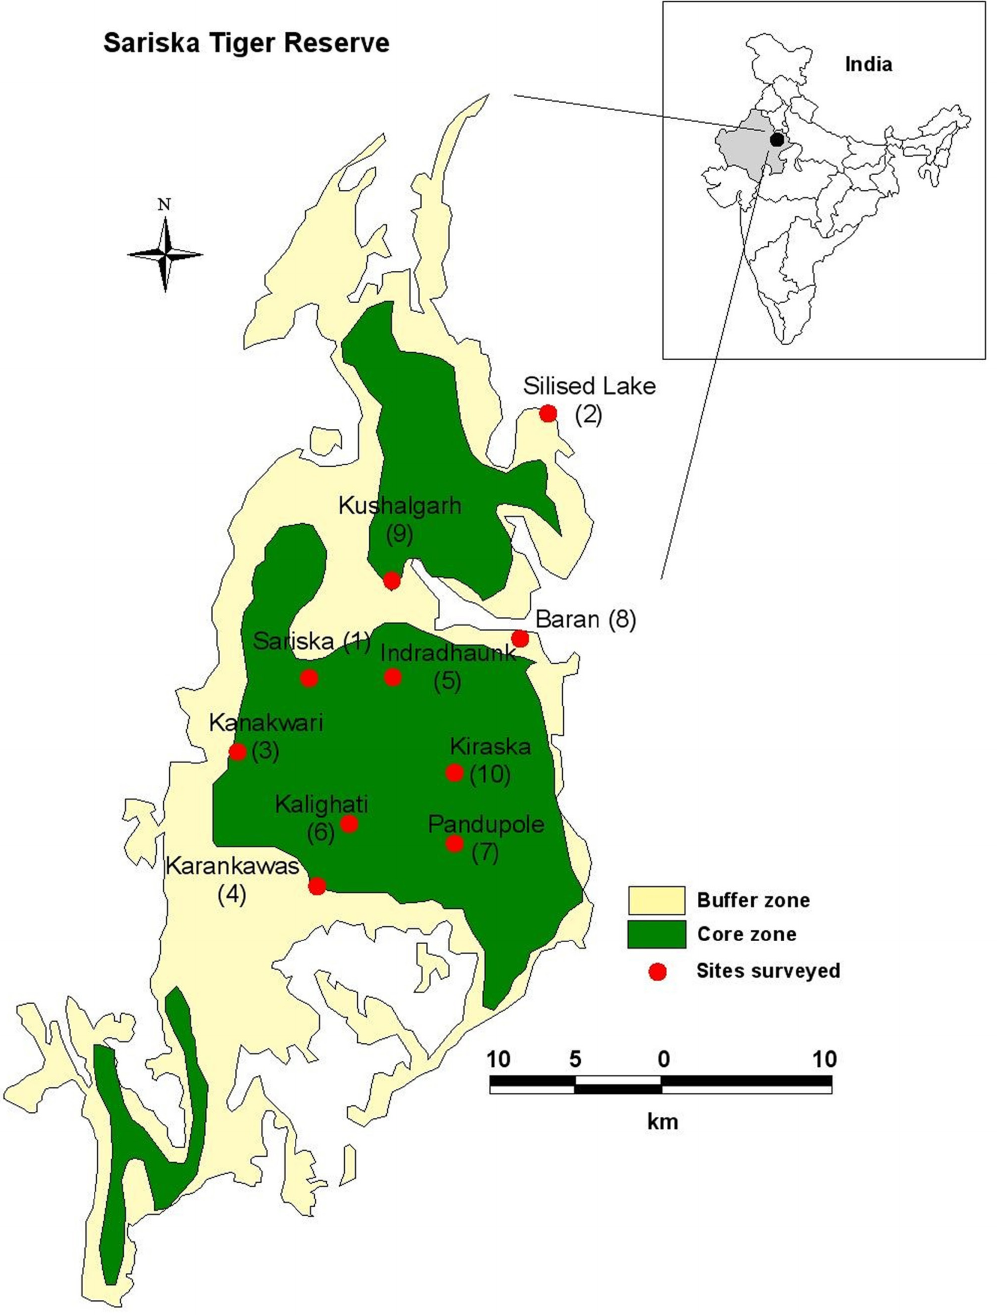
Figure 1. Map of Sariska Tiger Reserve, Rajasthan, India showing surveyed